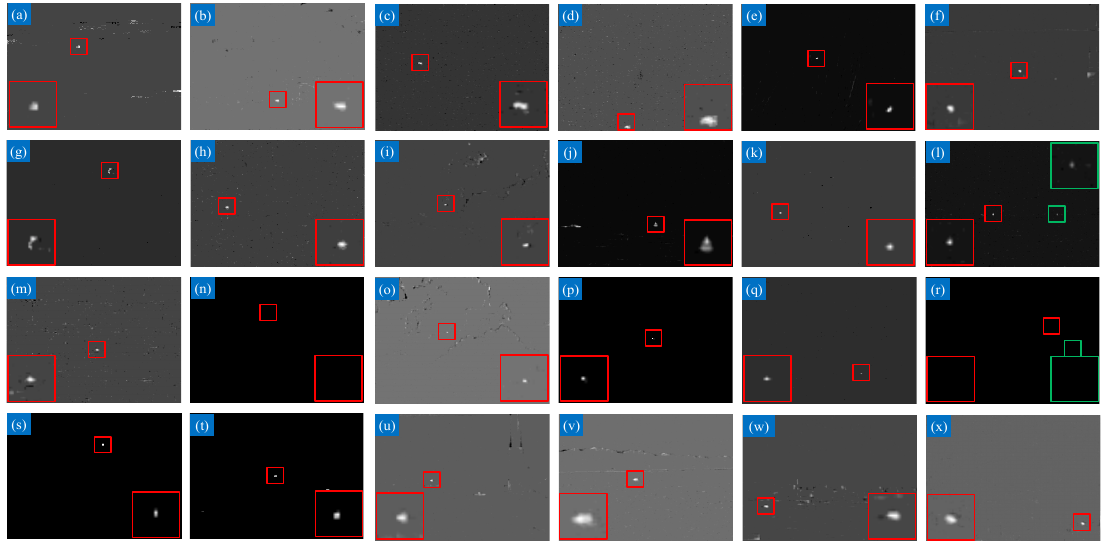
Figure A5. The separated target images of IPI under 24 scenes.